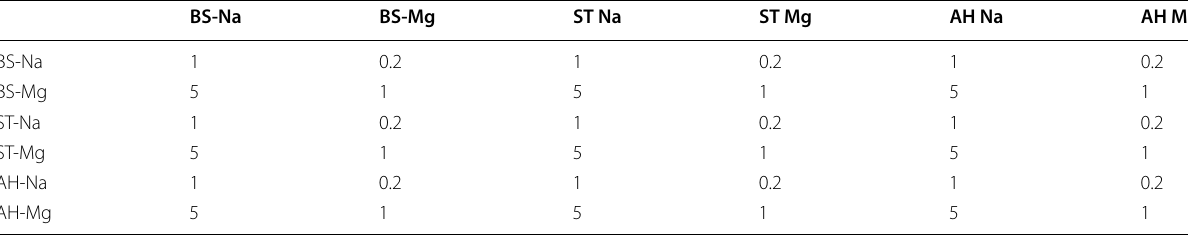
Table 8 Weight judgment matrix used for OR